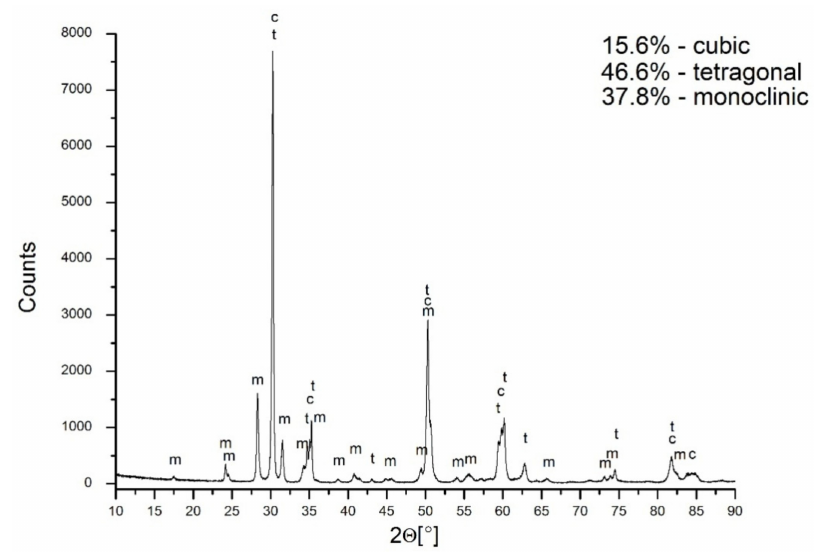
Figure 7. XRD of sintered sample at 1400 ◦ C for 2